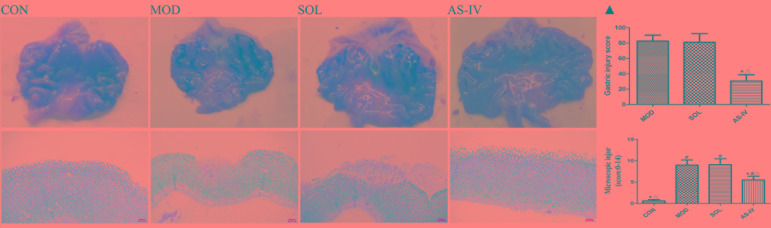
Intragastric administration of absolute ethanol triggered severe linear hemorrhagic damage and multifocal erosions in gastric mucosa, accompanied by submucosal edema, inflammatory cell infiltration, and epithelial cell loss (200×). Pretreatment with AS-IV alleviated these injuries. ▲ The analyses of gastric injury score and microscopic damage score. CON: control; MOD: model; SOL: solvent; AS-IV: AS-IV (4 mg/kg). Significant difference (*P < 0.05) when compared with the model group. Significant difference (#P < 0.05) when compared with the control group. Significant difference (∆P < 0.05) when compared with the solvent group. N = 6–8.